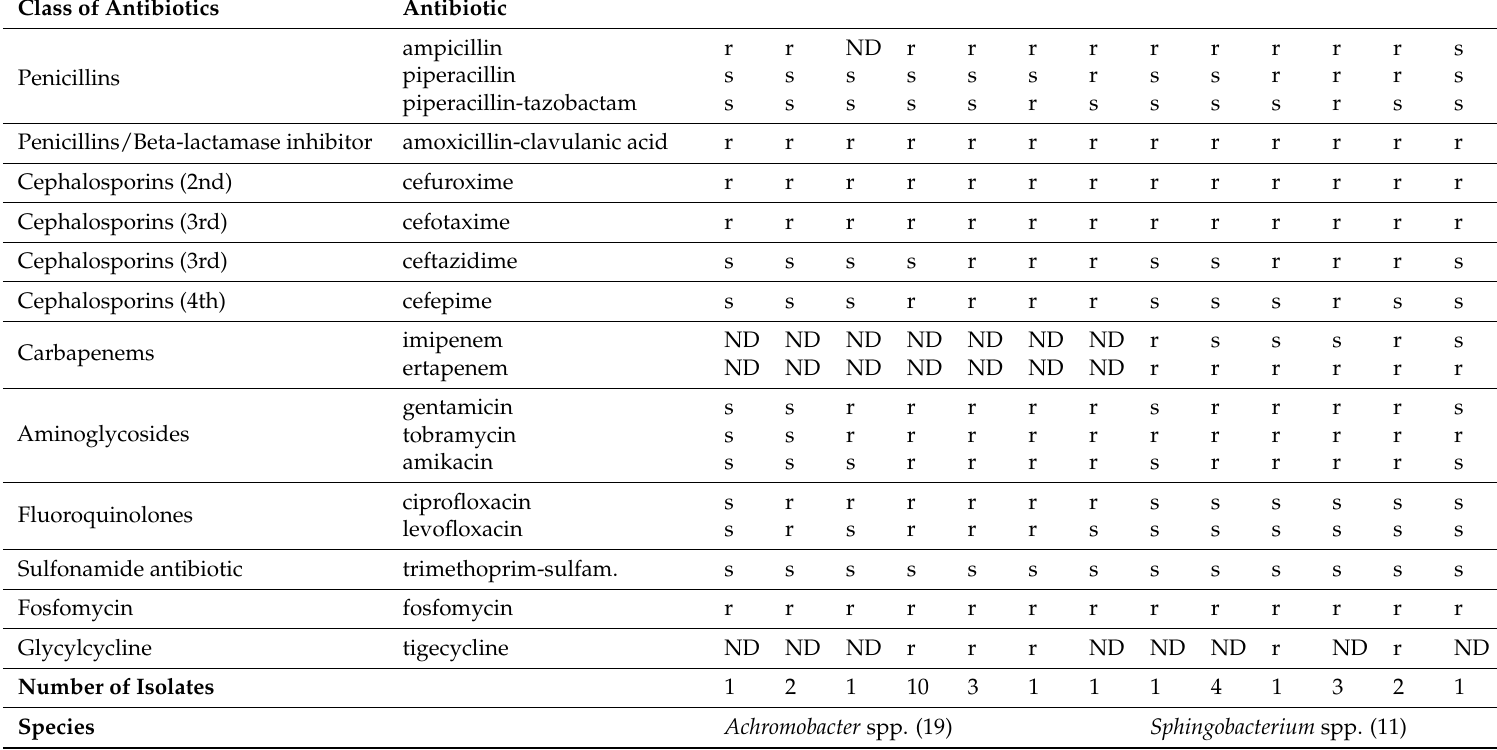
Table 6. Antibiotic resistance patterns of all Achromobacter spp. and Sphingobacterium spp. isolates from water and surface samples. Class of Antibiotics Antibiotic ampicillin Penicillins